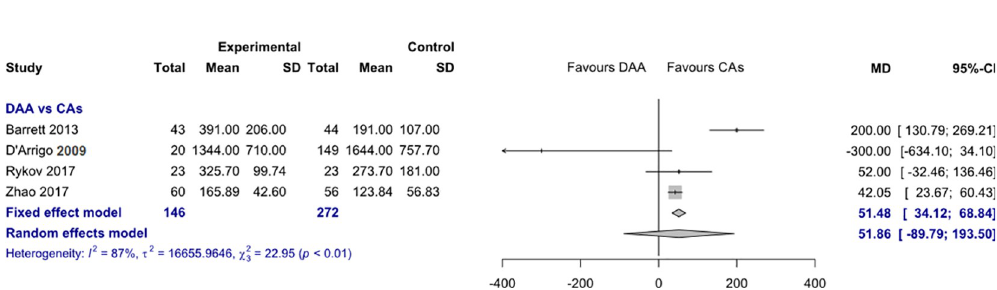
Fig 4. Comparison of the intraoperative blood loss in ml. DAA, direct anterior approach; CAs, conventional approaches; SD, standard deviation; MD, mean difference; CI, confidence interval.